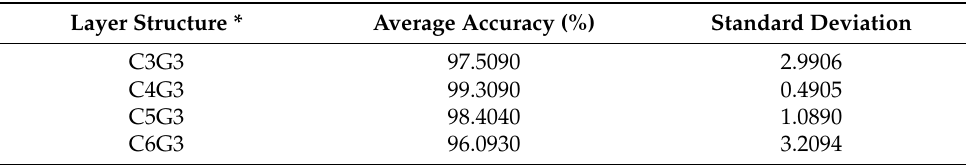
Table 2. The classification results according to changes in the number of convolutional layers of the 1D